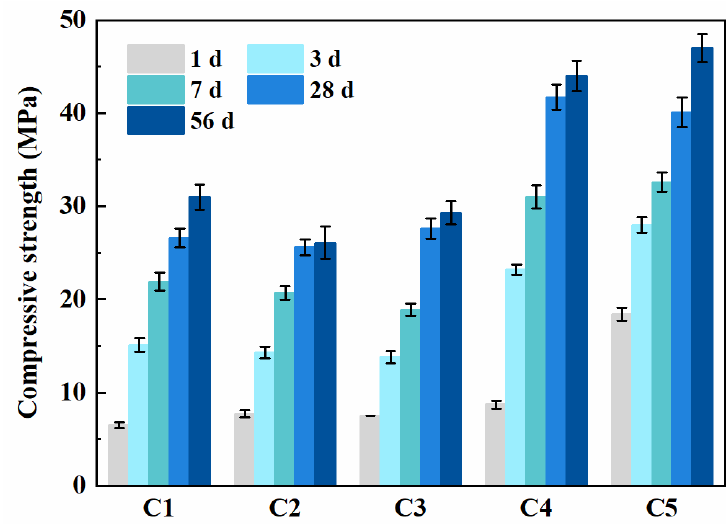
Figure 4. The compressive strength of SCC.